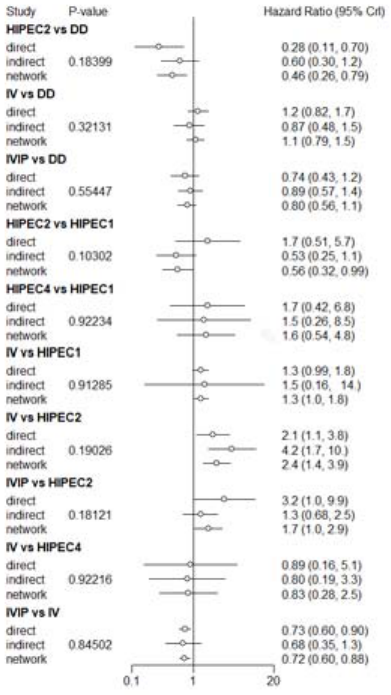
Figure A5. Result of node ‐ splitting analysis for OS.